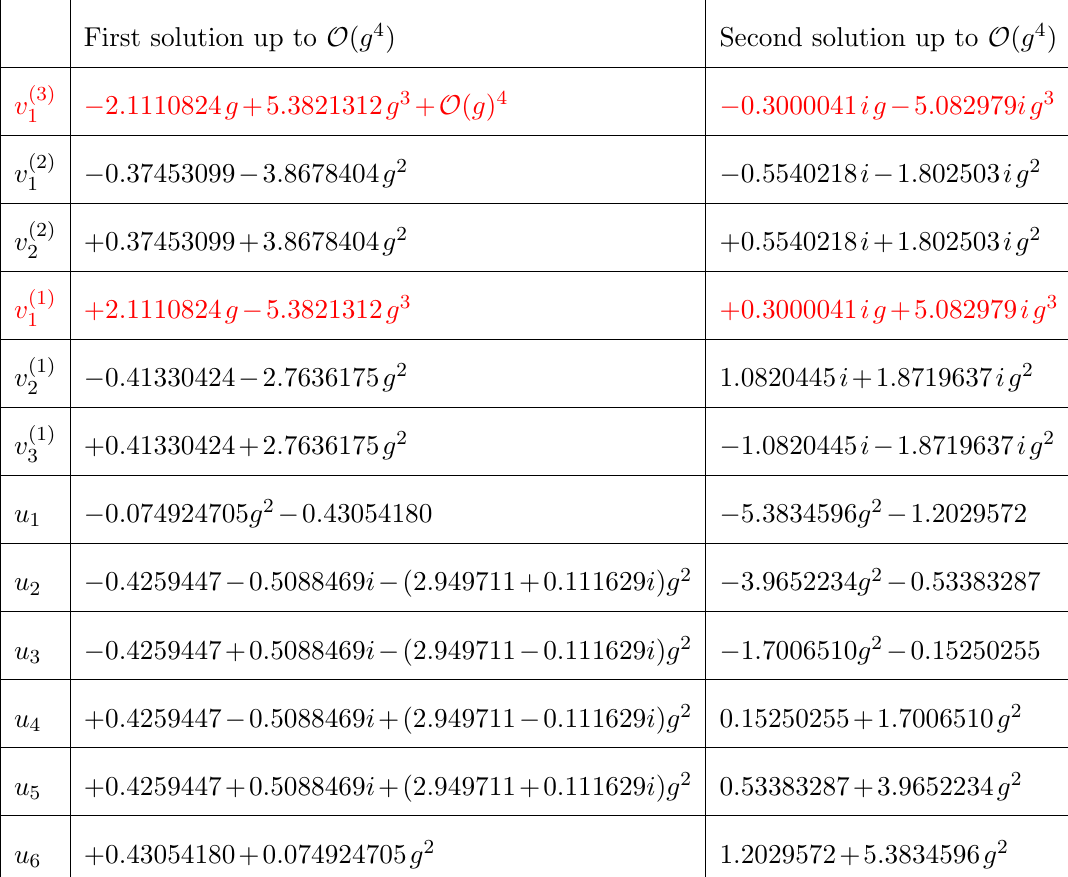
Table 2. The two wing-symmetric Bethe solutions for L = 4 , (cid:1) 0 = 6, s = 0, n = 0 and m = 0 in the sl (2)-grading. The roots in red vanish at g , with v (3) = v (1) . The next correction is of 1 1 (cid:0)